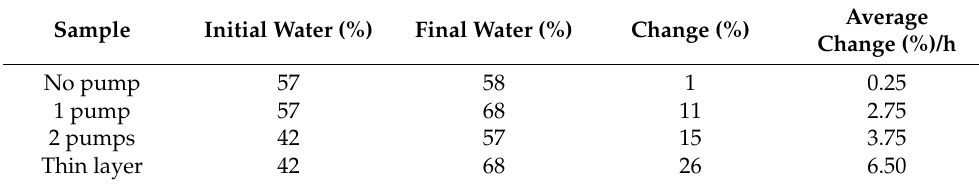
Table 1. Absorption rate with different